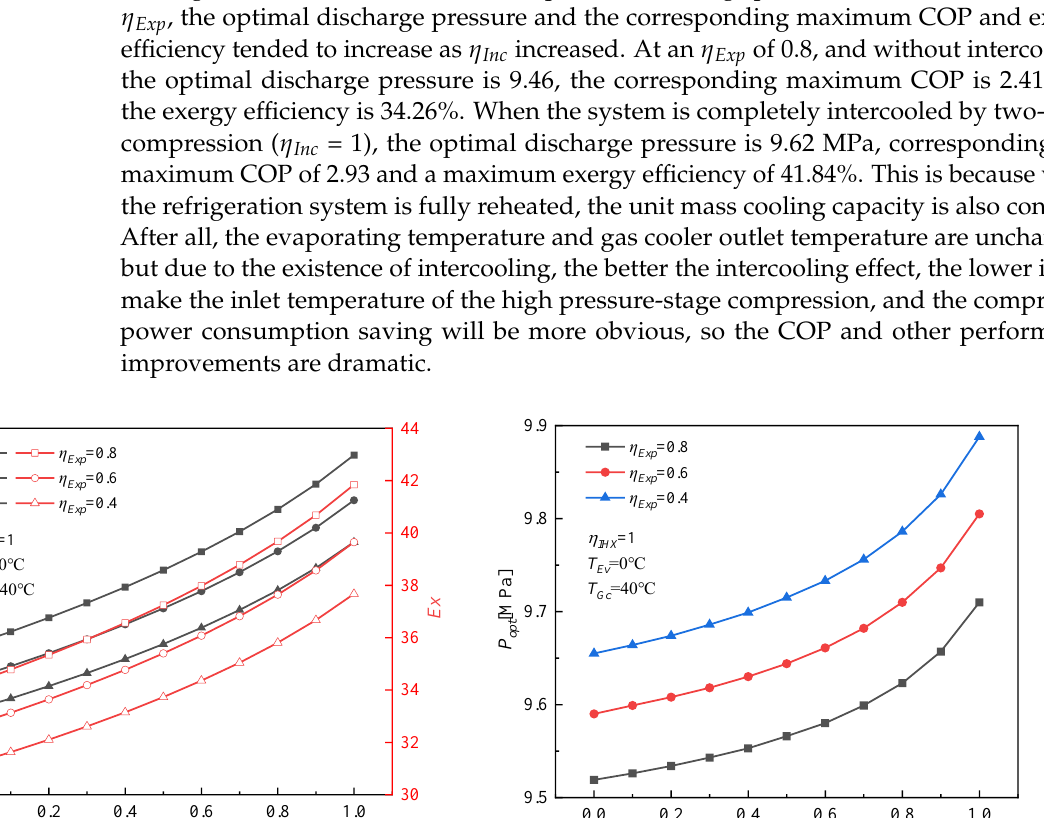
( b ) Figure 9. Three-dimensional plot of η IHX and η Inc on system performance: ( a ) Variations of COP; ( b ) Variations of the exergy efficiency. 3.4. Effect of Evaporation Temperatures on System Performance With a gas cooler outlet temperature of 40 °C, and an evaporation temperature of different values, the performance of the trans-critical CO 2 refrigeration system changes as shown in Figure 10 (a), depicting the system without IHX as well as η IHX = 1 conditions, the evaporation temperature on the system COP and the change in the exergy efficiency.